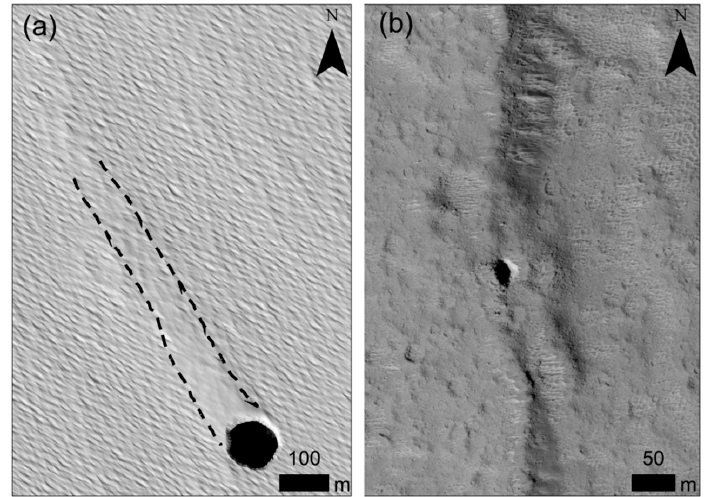
Figure 11. HiRISE view of pit craters of different dimensions: ( a ) a collapsed skylight with a possible subterranean hollow space (marked by black dotted lines) evident due to the textural differences (Scene ID: ESP_013167_1785); ( b ) a small pit crater in an otherwise intact lava tube (Scene ID: ESP_012863_1915). HiRISE image credit: NASA / JPL / University of Arizona.